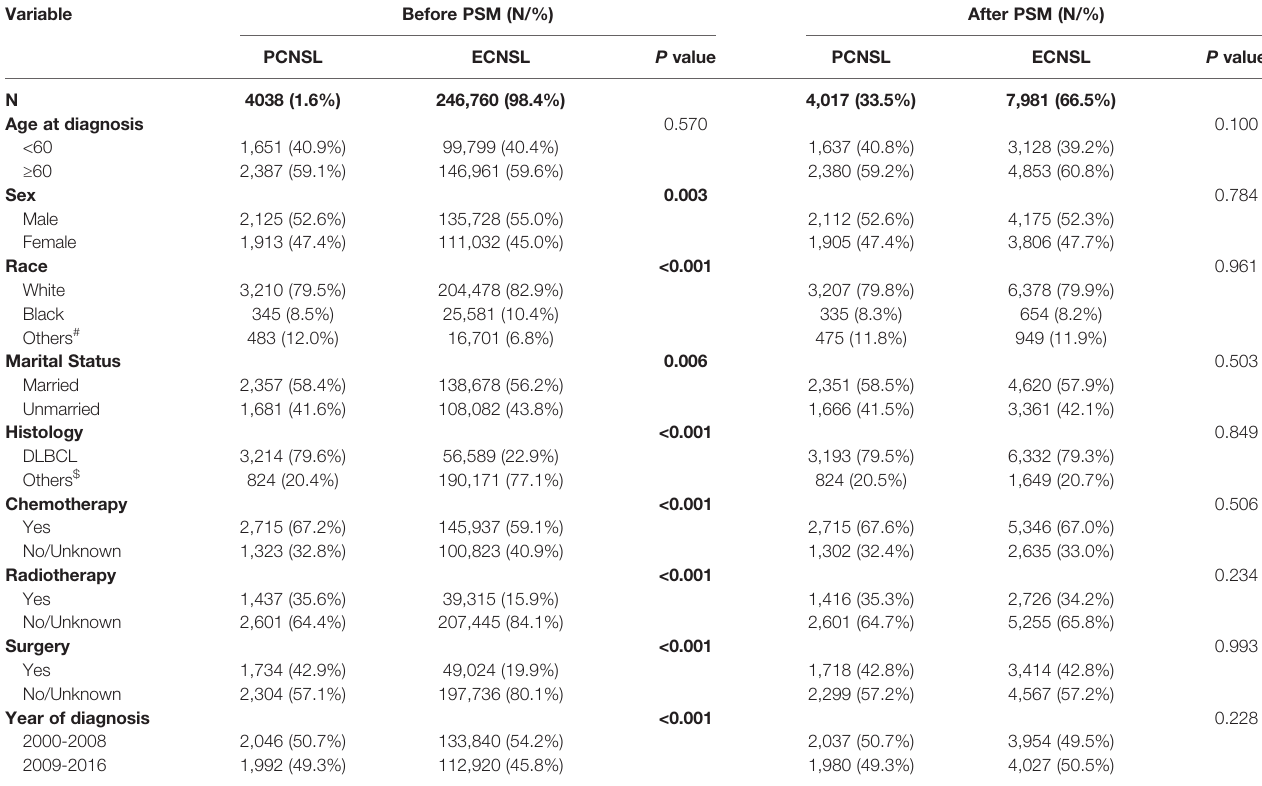
TABLE 1 | Baseline characteristics of PCNSL and ECNSL before PSM and after